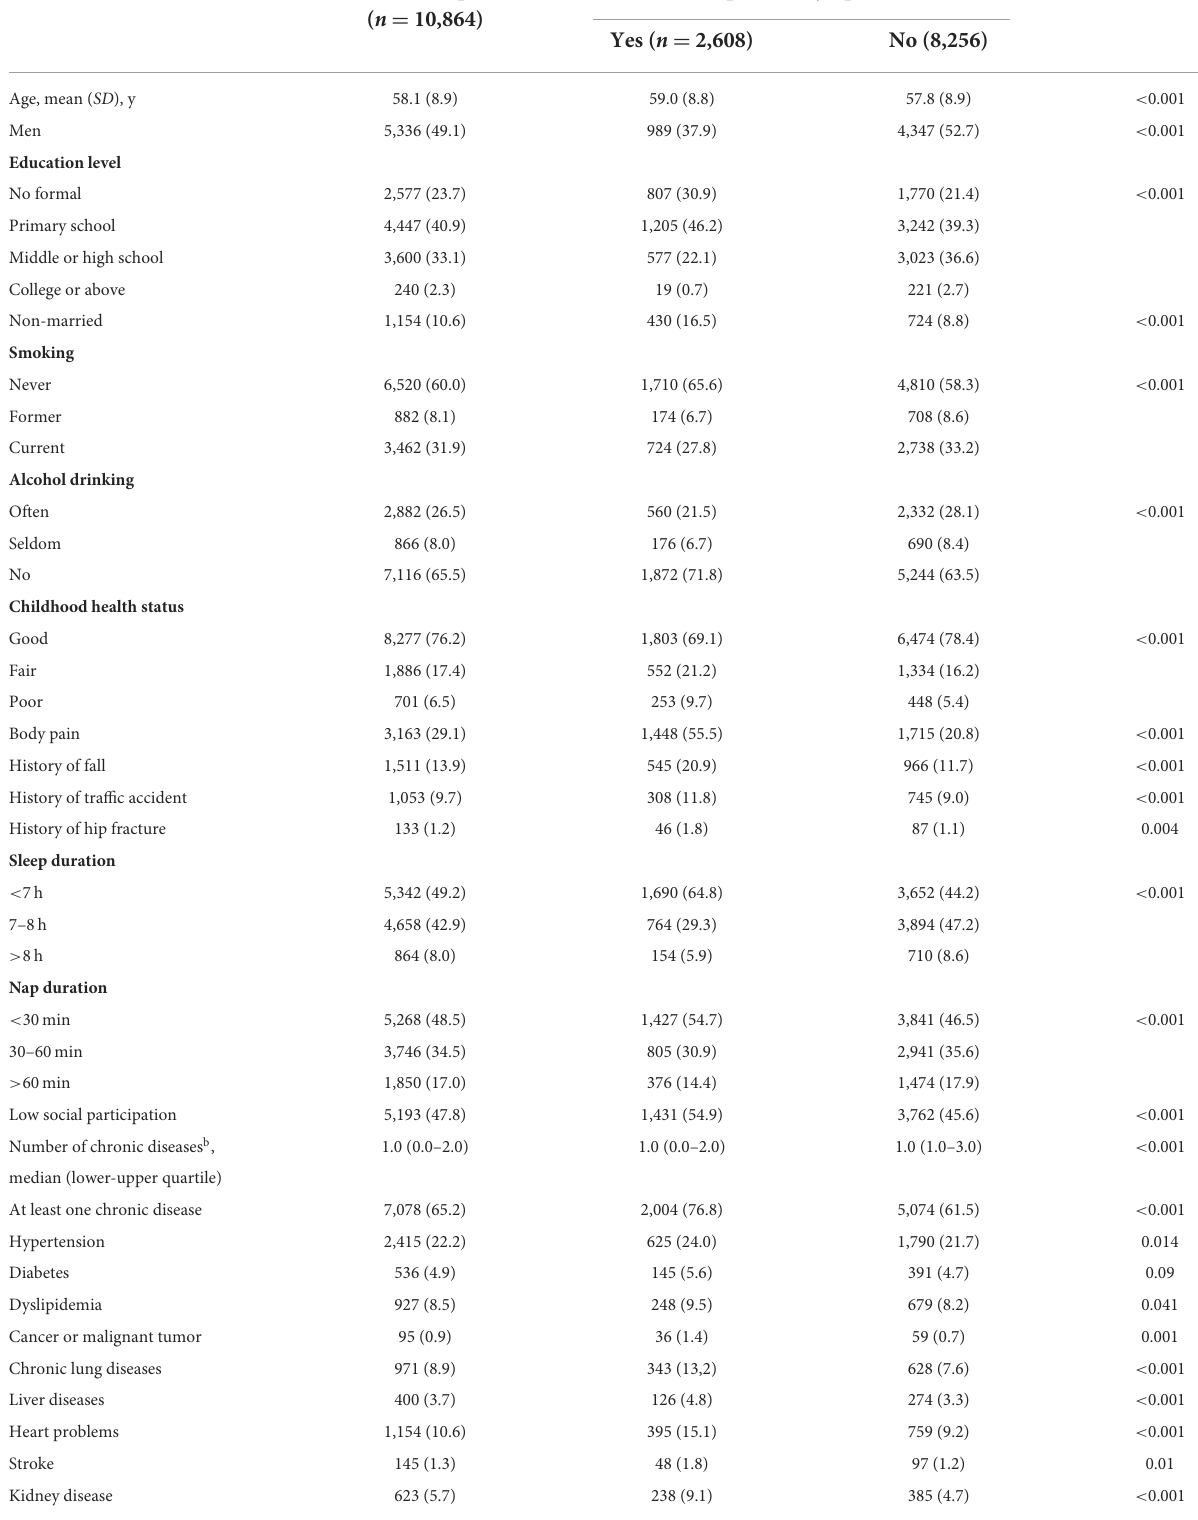
TABLE 1 Baseline characteristics of participants according to depressive symptoms